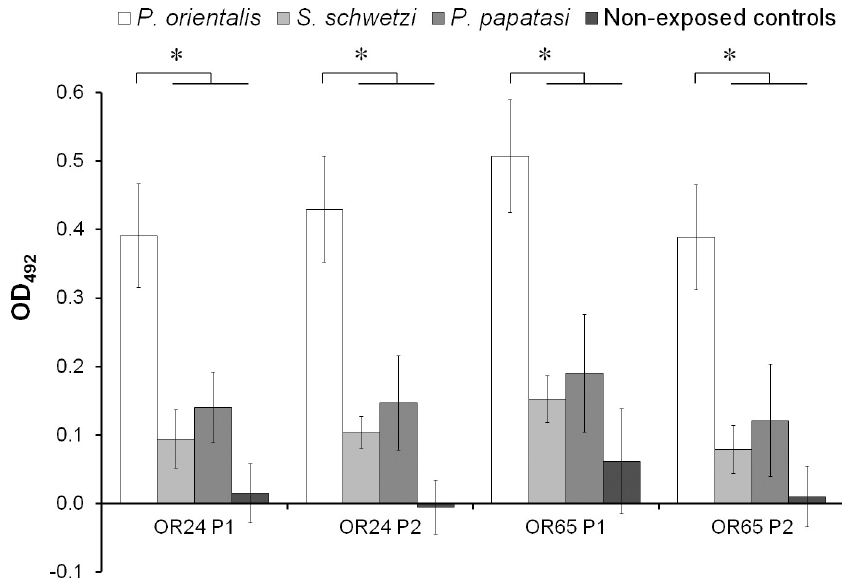
Fig 2. Specificity of peptides. Results from ELISA are presented as mean optical densities (with control values subtracted, from wells without serum) ± standard deviation of IgG antibody reaction, with four peptides (OR24 P1, OR24 P2, OR65 P1 and OR65 P2) and with sera from mice experimentally bitten by P . orientalis , P . papatasi , S . schwetzi , and non-exposed control mice. Five mice per sand fly colony and five non-exposed controls were used. Cut- off values were 0.144 for OR24 P1, 0.112 for OR24 P2, 0.292 for OR65 P1, and 0.143 for OR65 P2. Asterisks ( � ) indicate significant differences (p < 0.05, calculated with non-parametric Wilcoxon Rank-Sum Test) between IgG levels of mice bitten by P . orientalis , bitten by other sand fly species, and unbitten controls.